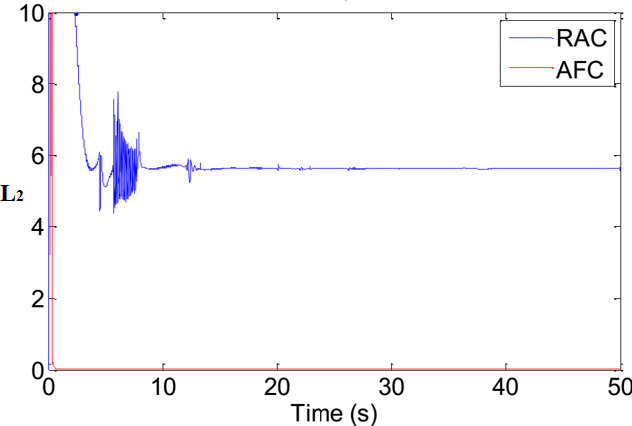
Figure 5. The magnitude of the second arm joint position tracking error.